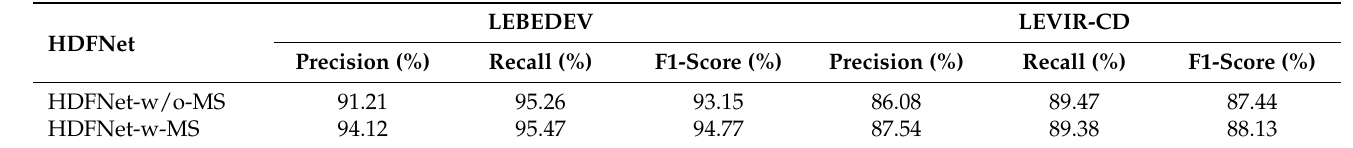
Table 7. Ablation study of with/without Multilevel Supervision.